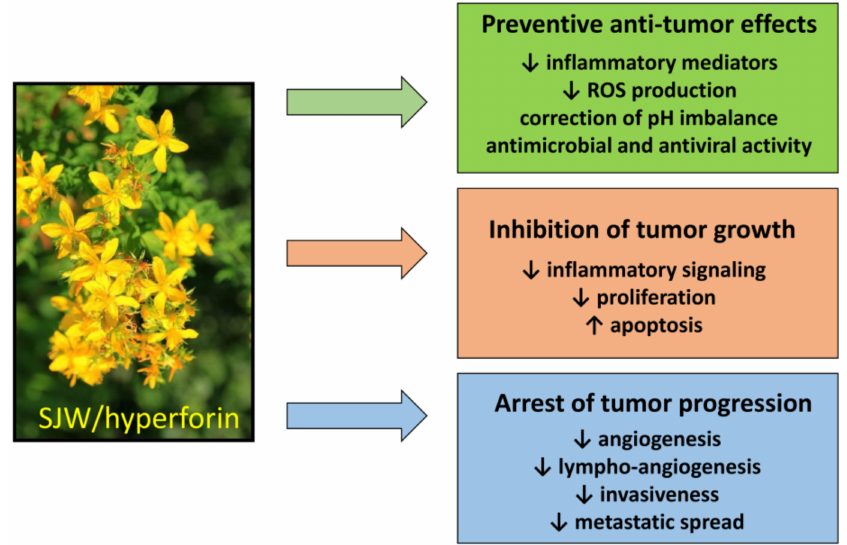
Figure 4. Antitumor effects of SJW and HPF. SJW and HPF display many antitumor effects with regard to both prevention and therapy of neoplastic diseases by acting on many different intracellular